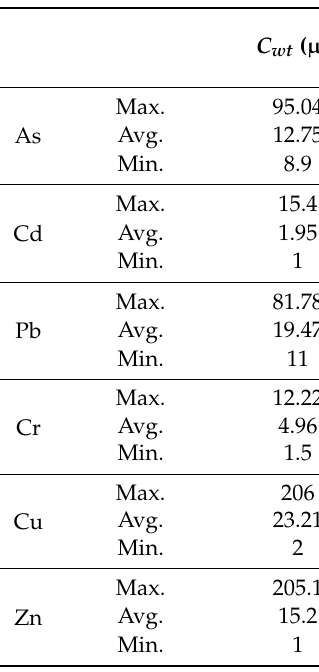
Table 3. Heavy metals concentration ranges, reference dose, and hazard quotient (HQ) for children and adults. RfD: reference